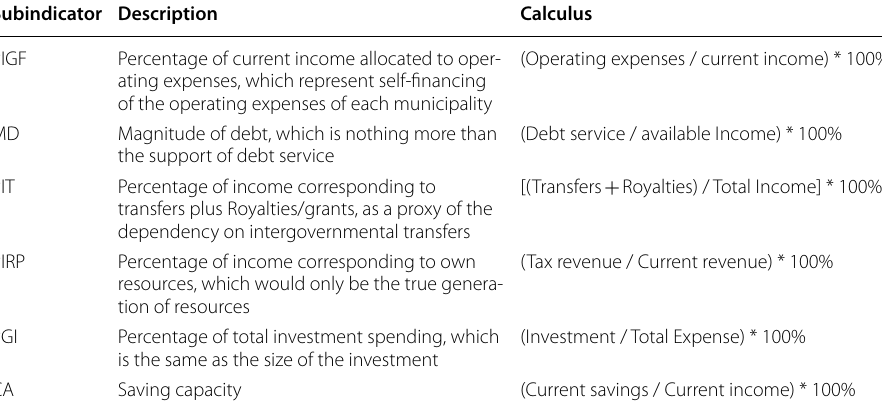
Table 1 Subindicators of the Fiscal Efficiency